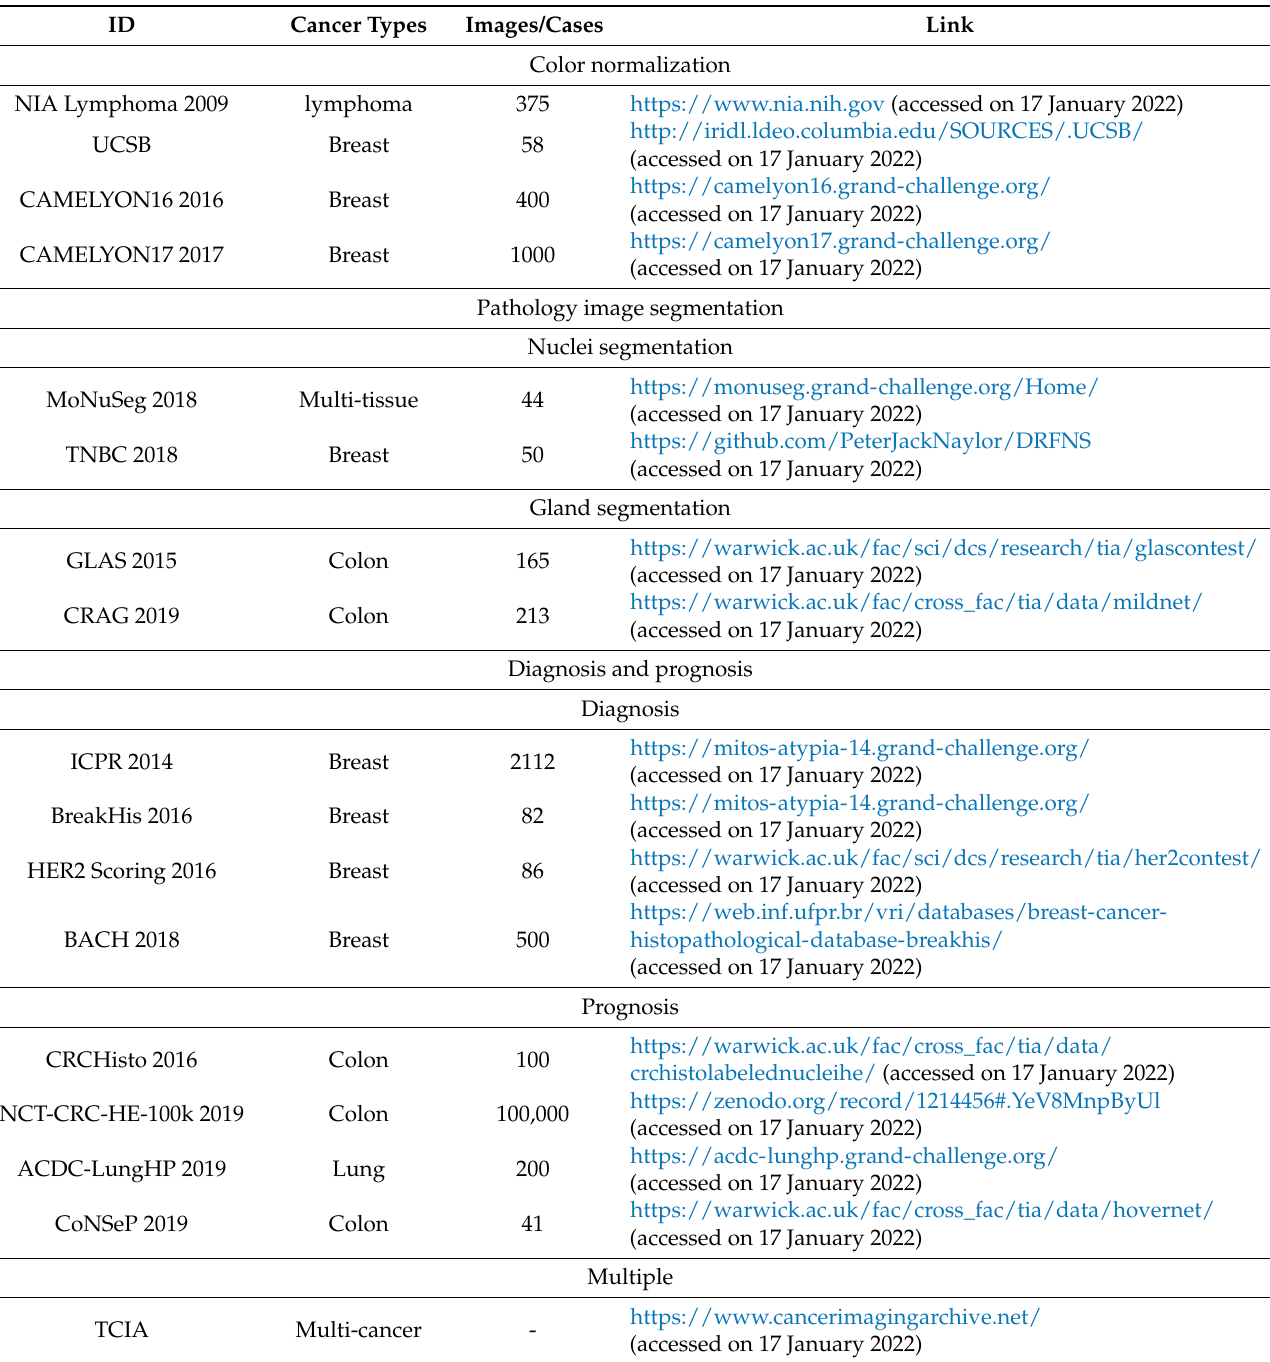
Table 2. Summary of publicly available databases in computational